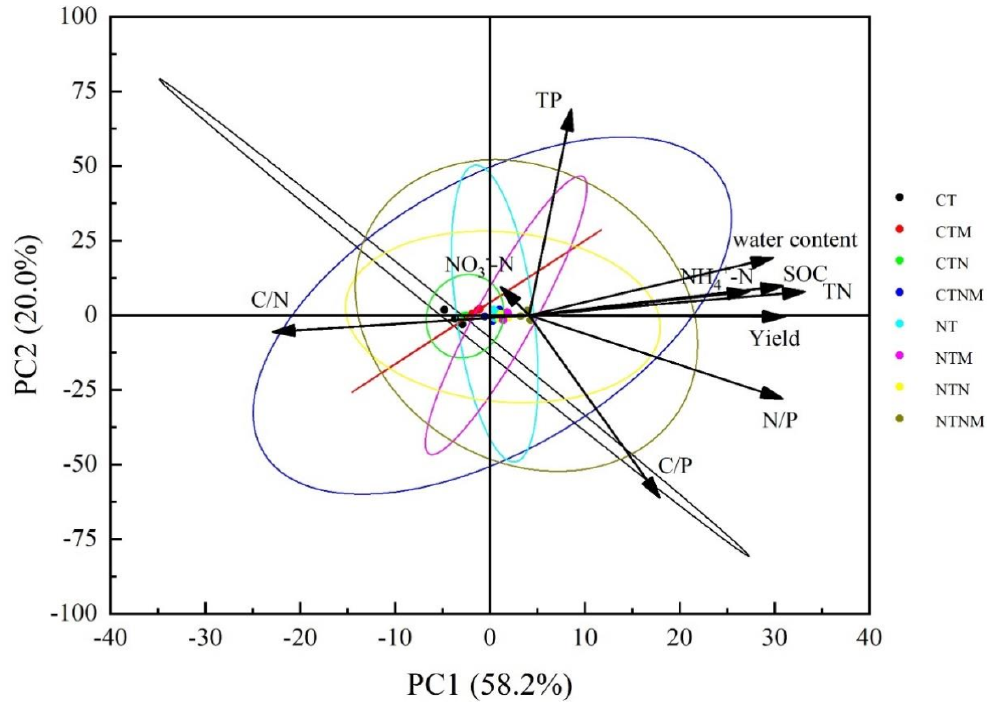
Figure 5. Principal component analysis of yield, SWC, soil nutrients, and stoichiometric characteristics.